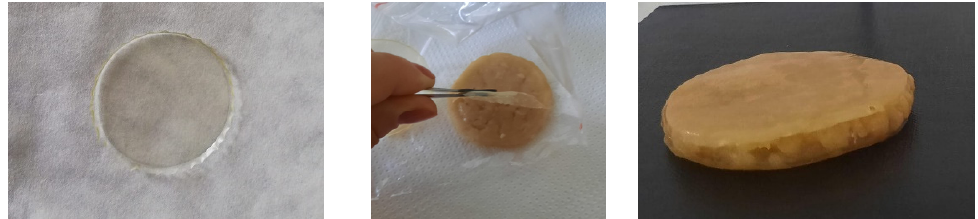
Figure 1. Protein-based packaging material depicted in the online survey.